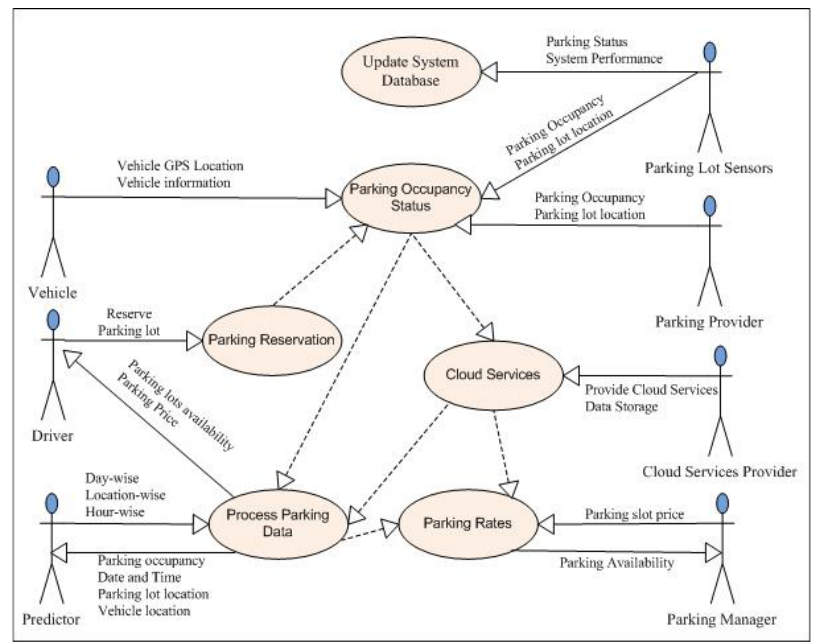
Figure 1. Internet of Things (IoT) based smart parking system use case diagram.